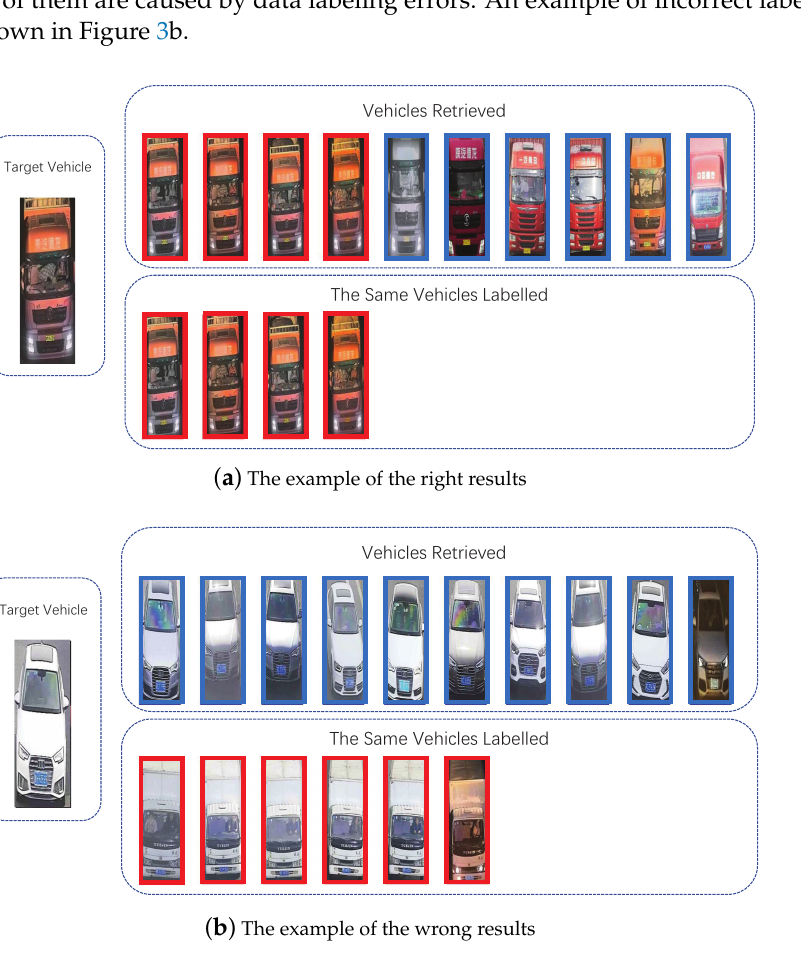
Figure 3. The example of the search